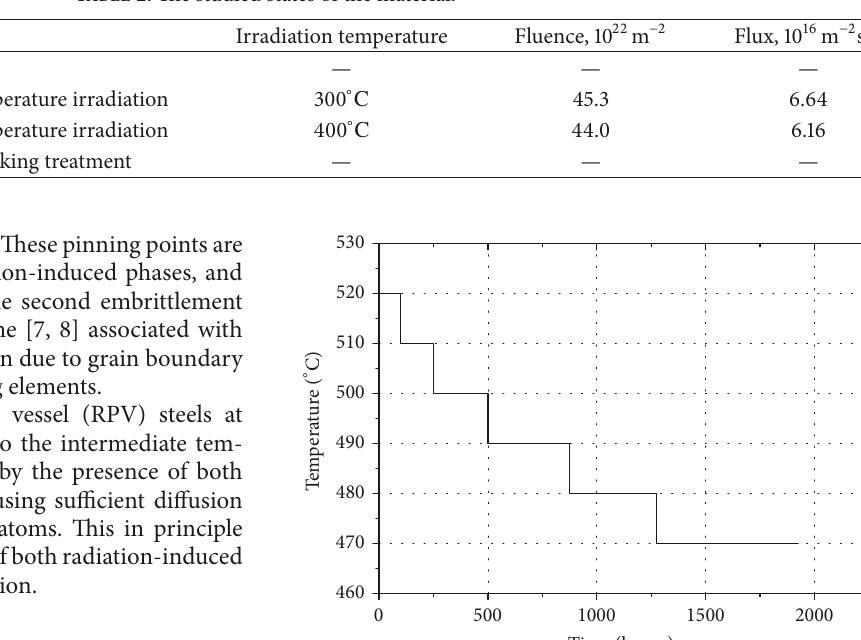
each temperature phosphorus diffusion length was the